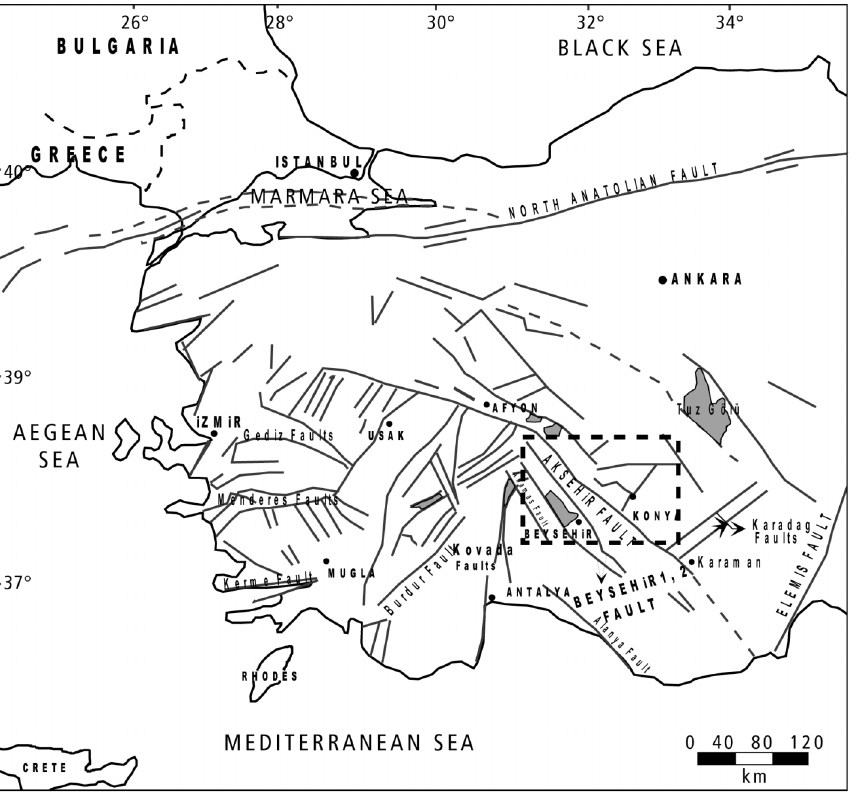
Fig. 5. Location map of the studied area and fault pattern of south-west Turkey (dashed area is modified from Kocyigit,